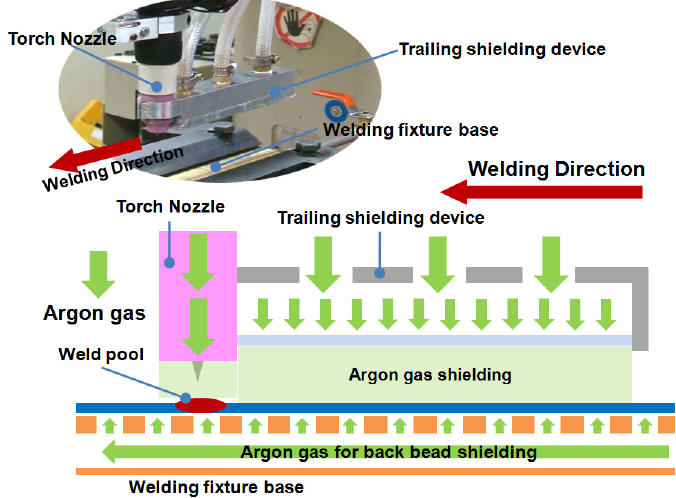
Figure 1. Illustration of welding test of Ti-3Al-2.5V and tungsten inert gas (TIG) dressing.